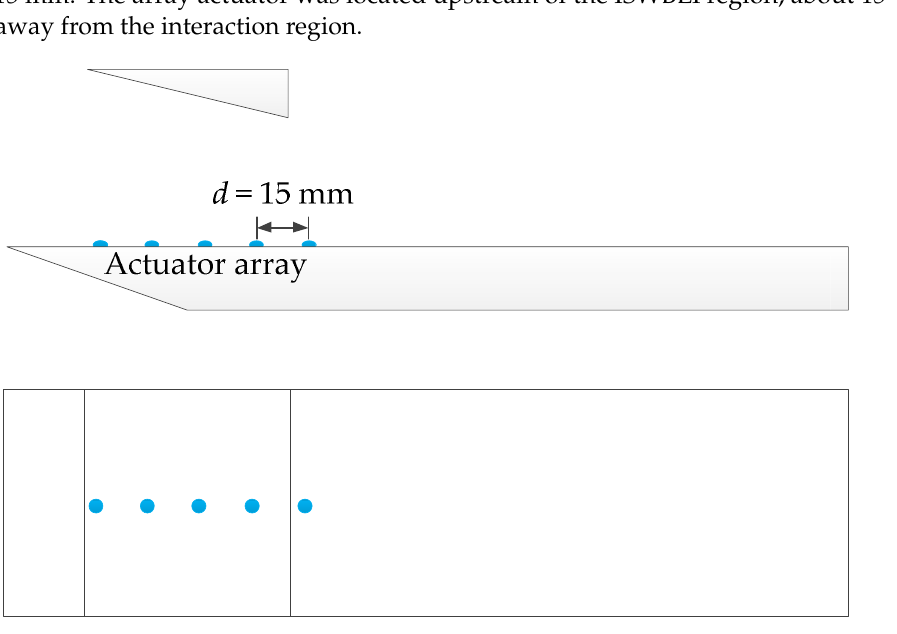
Figure 19. The schematic diagram of array actuation model.